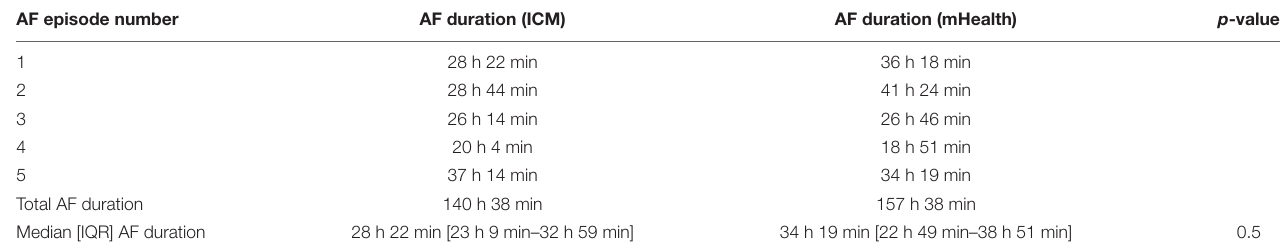
TABLE 1 | Duration of the AF episodes based on ICM and PPG-based mHealth.